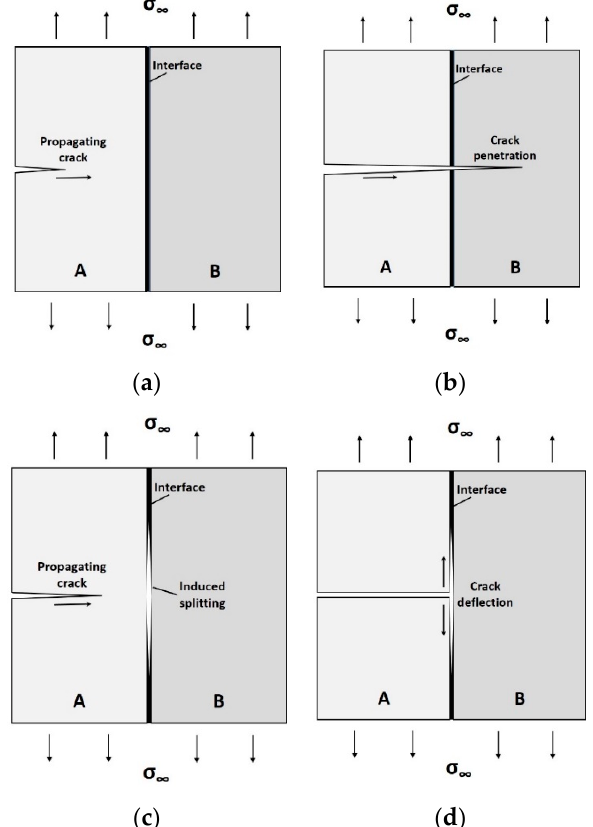
Figure 1. Propagation paths of a crack in a bi-material layered structure: ( a ) initial state; ( b ) crack crossing an interface in a self-similar fashion; ( c ) crack splitting at interface ahead of the crack tip (the Cook – Gordon mechanism [2]); ( d ) crack bifurcation at interface.